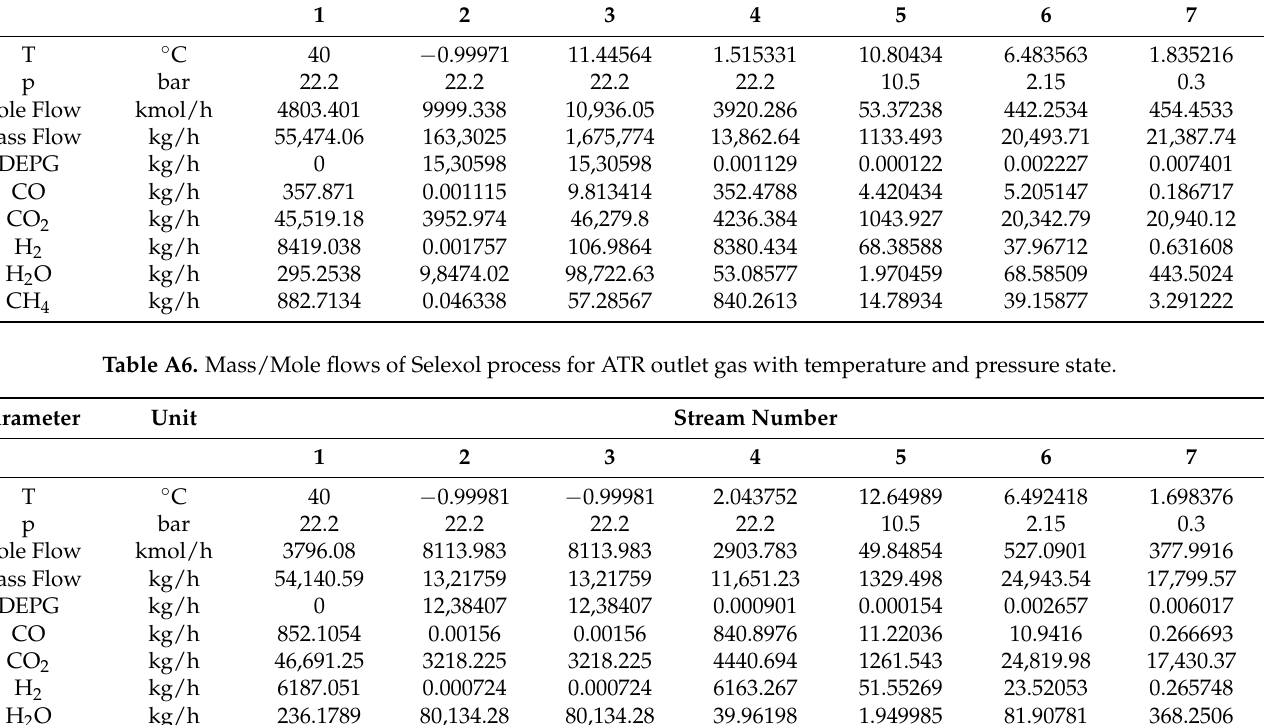
Table A5. Mass/Mole flows of Selexol process for SMR outlet gas with temperature and pressure state. Parameter Unit